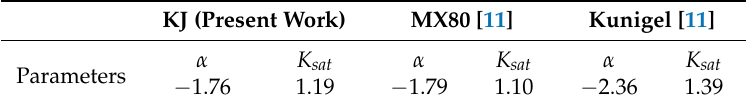
Table 8. Parameters from Equation